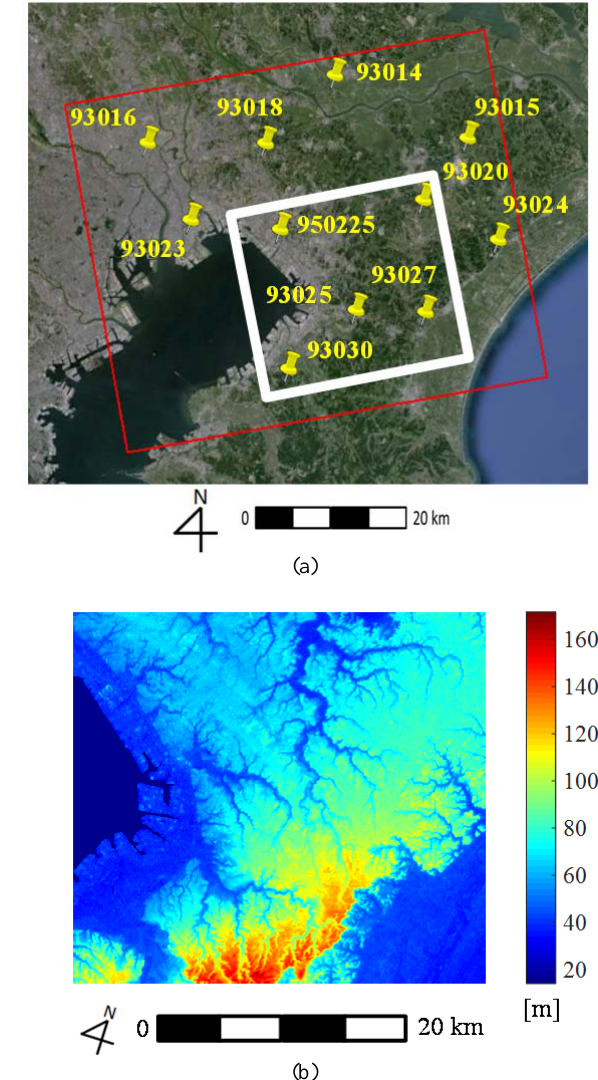
Figure 1. Study area. (a) Chiba, near Tokyo, Japan. Red and white rectangles denote areas of PALSAR image and analysis in this research, respectively. Yellow letters denote IDs of GPS base stations, operated by Geography Survey in Japan. (b) DEM derived from SRTM (90-m spatial